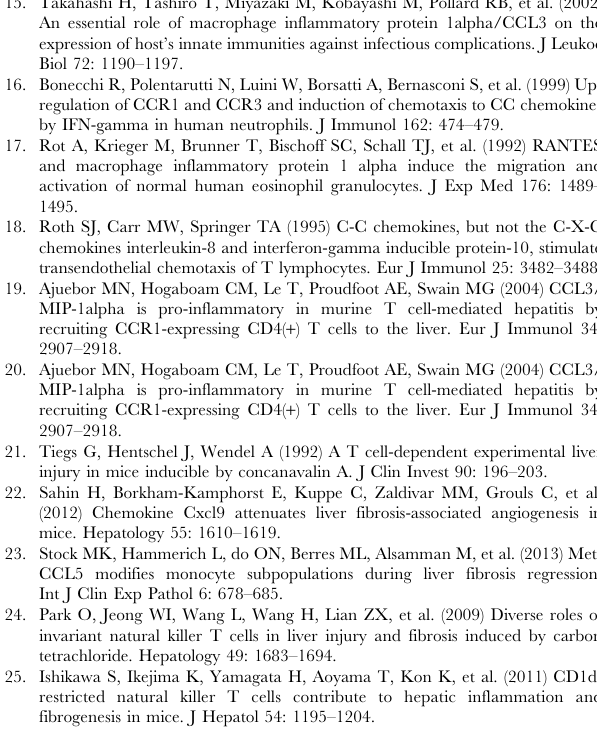
Figure S2 Reduced liver injury and inflammation in CCL3 2 / 2 mice. TUNEL + cells (TUNEL staining, x100 magnification) within the liver were significantly reduced in CCL3 2 / 2 mice compared to CCL3 + / + mice after six weeks of CCl 4 treatment ( A ). Absolute CD45 + , CD3 + and CD8 + cell numbers are markedly decreased in CCL3 2 / 2 mice ( B ). * P , 0.05. (TIF) Figure S3 CCL3 deficiency results in reduced influx of macrophages. F4/80 + cells (F4/80 staining, x100 magnifica- tion) within the liver were significantly decreased in CCL3 2 / 2 mice compared to CCL3 + / + mice after six weeks of CCl 4 treatment. * P , 0.05. (TIF) Figure S4 CCL3 accelerates proliferation and migration of stellate cells. Representative pictures of scratch assay (x200 magnification). The pictures show the scratches after 0, 24 and 32 hours after the stimulation with 20 ng recombinant CCL3.